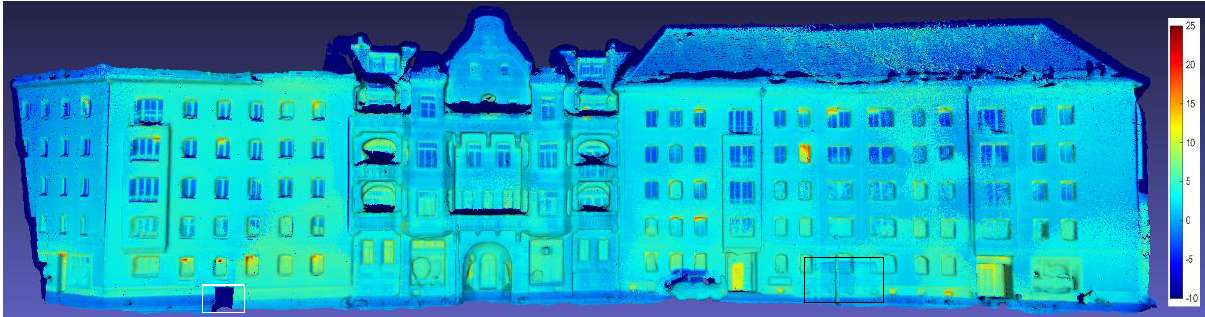
Figure 4. Texture selection results using equation